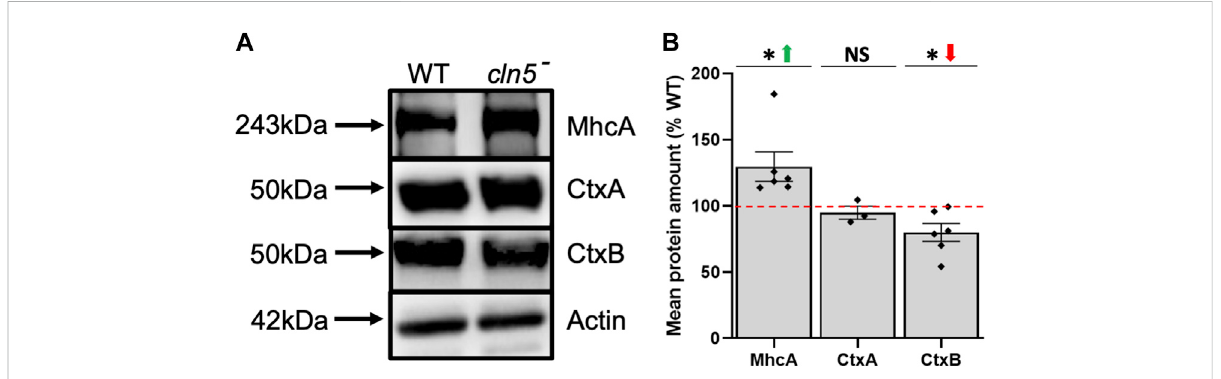
FIGURE 3 Loss of cln5 affects the abundance of proteins linked to cytokinesis during growth. (A) Whole cell (WC) lysates (20-30 µg) from growth-phase WT and cln5 -de fi cient cells were separated by SDS-PAGE and analyzed by western blotting. Membranes were probed with anti-CtxA, anti-CtxB, anti-MhcA, and anti- β -actin (loading control). (B) Intracellular amounts of CtxA, CtxB, and MhcA were quanti fi ed using Fiji/ImageJ and standardized against the levels of β -actin. Data presented as mean protein amount (% WT) ± SEM ( n ≥ 3). * p < 0.05 (one sample t -test). NS – not signi fi